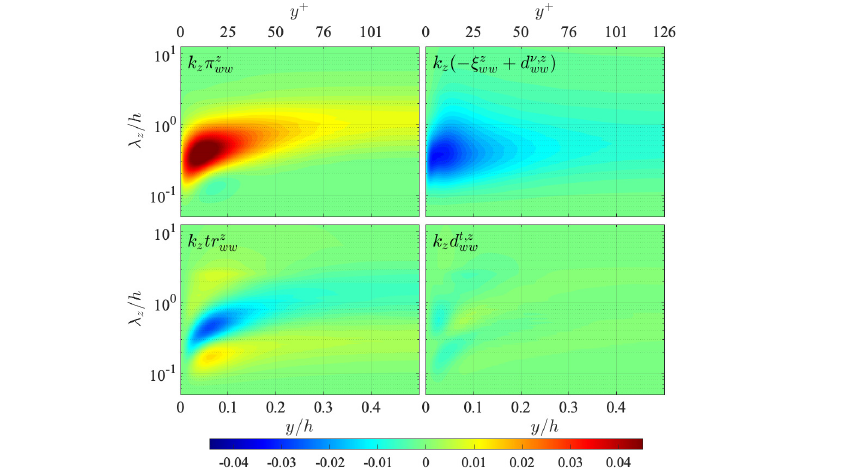
Figure A2. Distribution of terms in the transport equation of the wall-normal turbulent energy spectrum E z vv , presented in the same manner as in Figure 12: ( top left ) pressure-strain energy redistribution π z vv ; ( top centre ) viscous terms − ξ z vv + d ν , z vv ; ( top right ) pressure diffusion d p , z vv ; ( bottom left ) interscale transport tr z vv ; ( bottom right ) turbulent diffusion d t , z vv . The terms are presented in the premultiplied form, and the values are scaled by u 4 τ / ν .